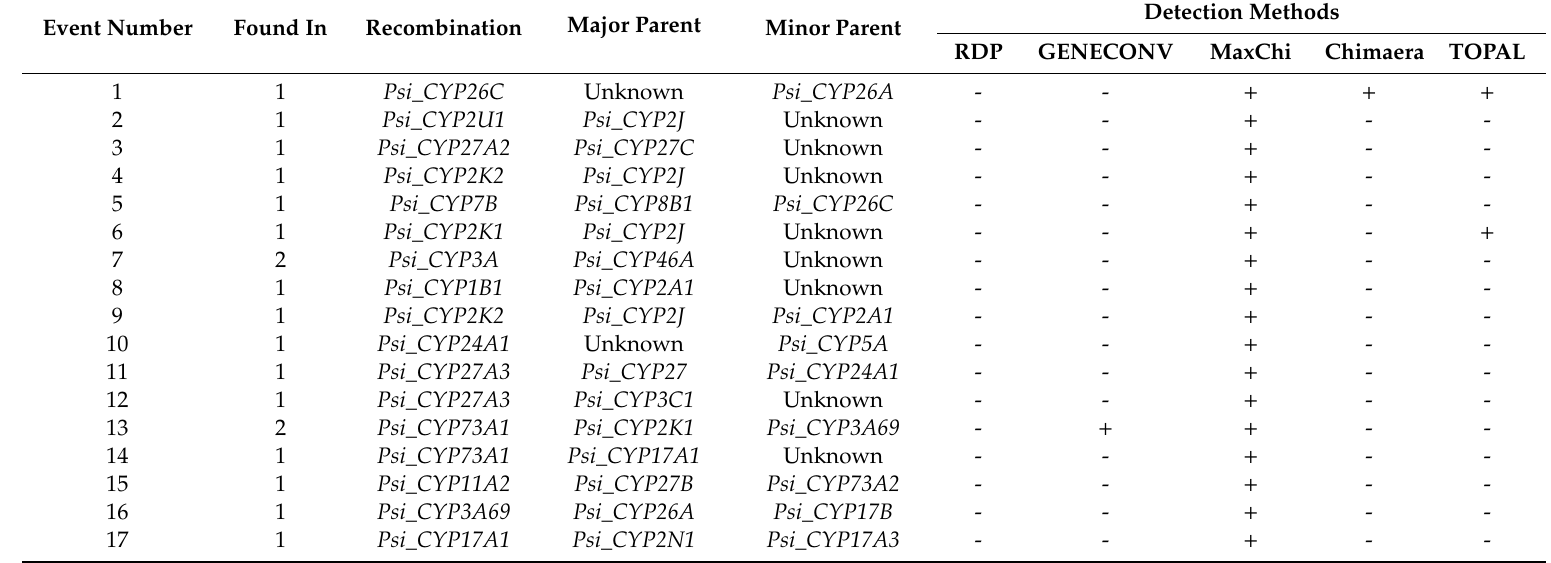
Table 2. Predicted recombination events among CYP genes in P. sinensis